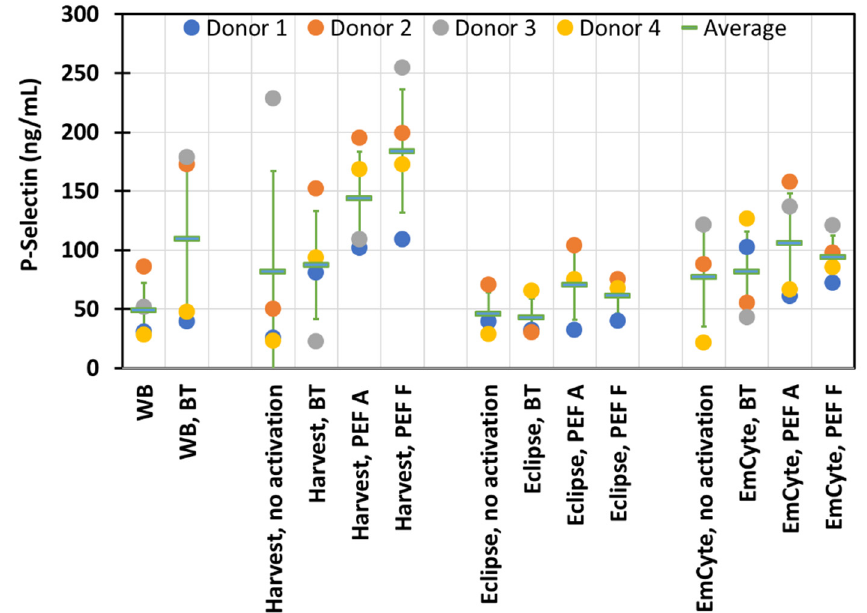
Figure A1. Soluble P-selectin release for: whole blood (WB)—no activation and bovine thrombin (BT) activation; Harvest PRP (no activation, bovine thrombin—BT—activation, and activation using electric stimulation with pulses A and F); Eclipse PRP (no activation, bovine thrombin—BT—activation, and activation using electric stimulation with pulses A and F); EmCyte PRP (no activation, bovine thrombin—BT—activation, and activation using electric stimulation with pulses A and F).